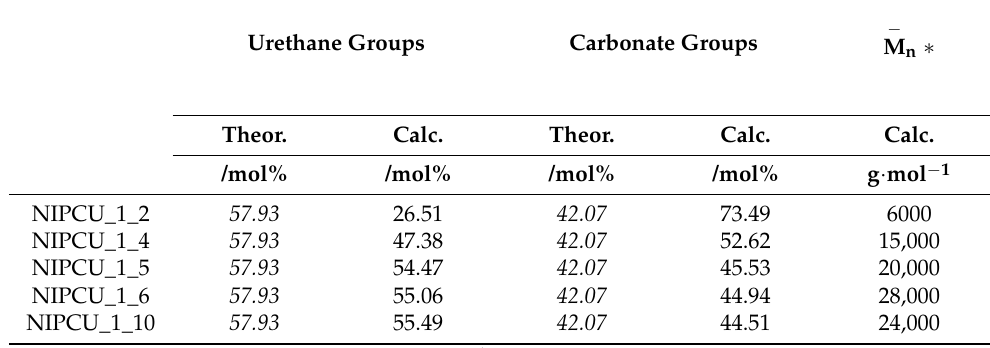
Table 1. Theoretical and calculated values of the concentrations of the urethane and carbonate groups, as well as the number-average molar masses of the NIPCUs.